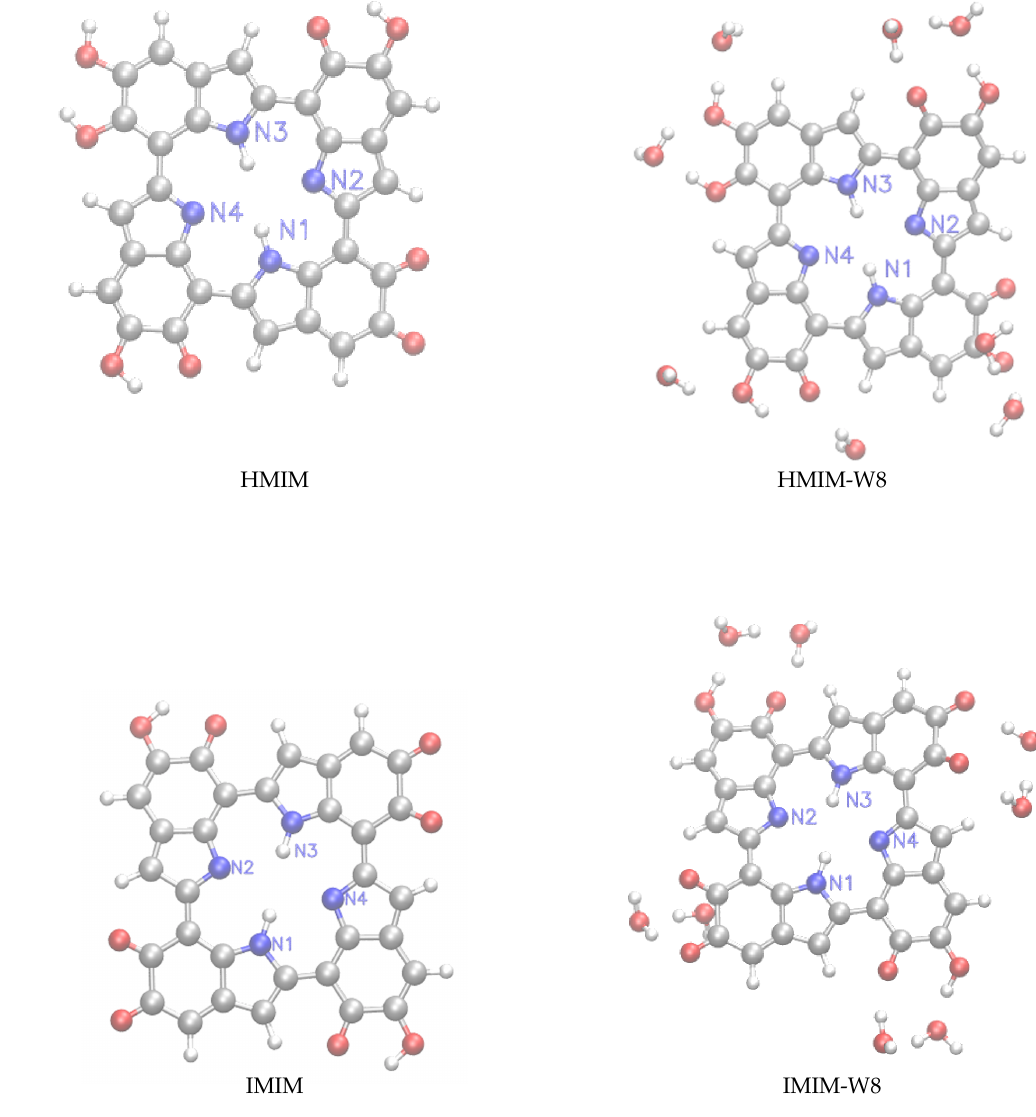
Figure 3. Left panels: structure of the HMIM ≡ HM+IM and IMIM ≡ IM+IM tetramers. Right panels: microsolvated structures with eight molecules (HMIM-W 8 , IMIM-W 8